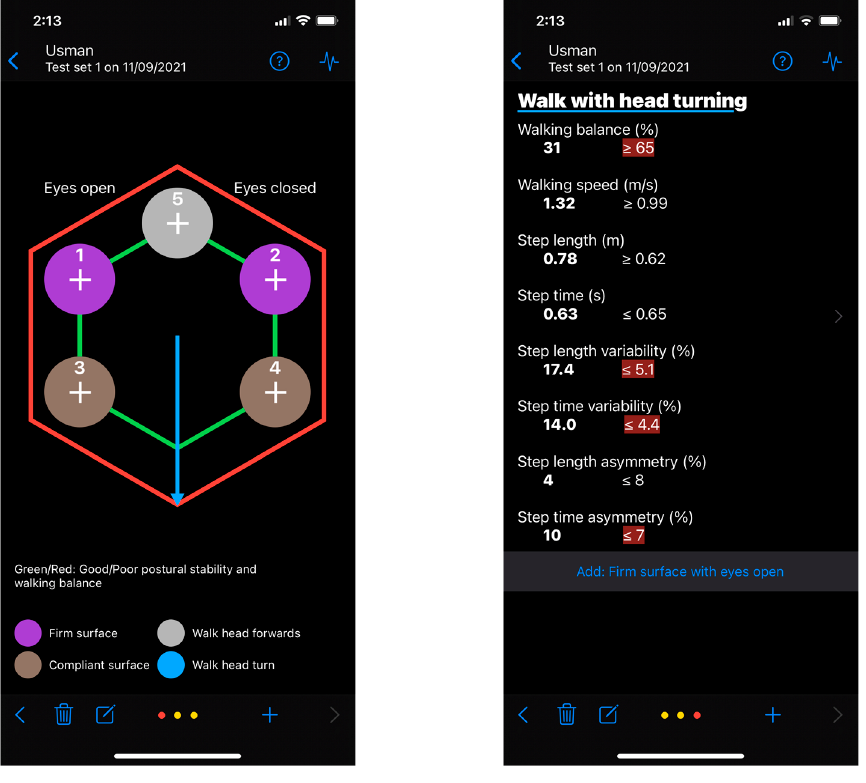
Figure 1. Screenshot images of the current version of the Gait&Balance application. Note: These screenshots were taken on the current beta version (0.3.4) and the app may change substantially in a future release.